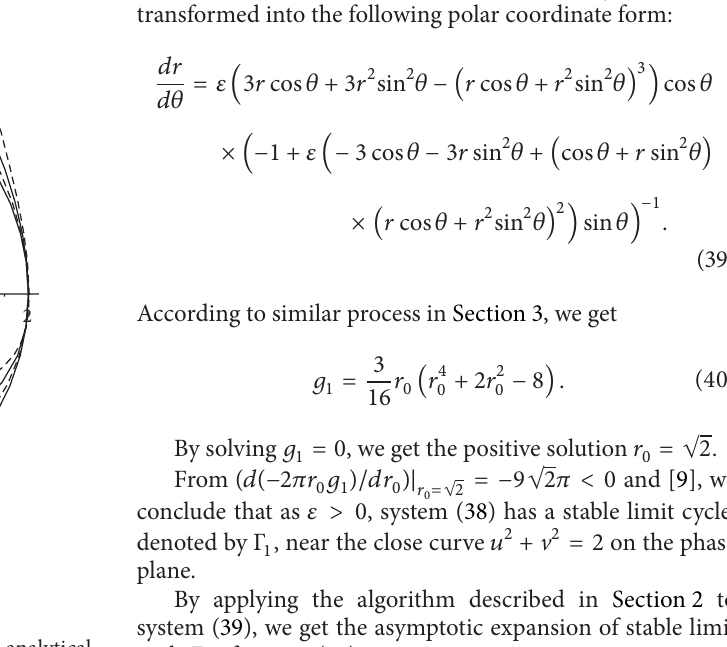
Figure 1: The periodic orbit 𝑥 2 + 𝑦 2 = 4 and the analytical approximations of the limit cycle of Van der Pol system (25), for the values 𝜀 = 0 , (1/5) , (1/2) , (9/10)